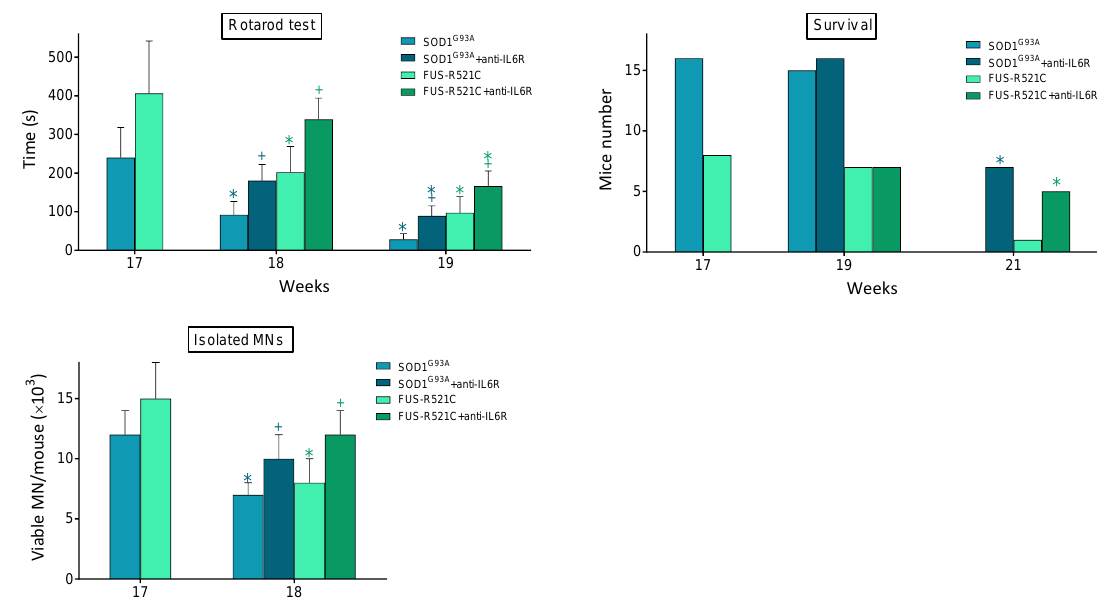
Figure 3. Effect of in vivo treatment with anti-IL6 mAbs on neuromotor function, survival, and MN viability of ALS mouse models. Antibody administration (one dose per day from week 17 to week 19), rotarod test (as in Figure 1), and isolation of MN were performed, as described in Methods. Data are mean values ± SD for n = 20. * p < 0.05 comparing weeks 18–21 versus week 17, + p < 0.05 comparing data obtained in anti-IL6R-treated mice versus controls treated with physiological saline.